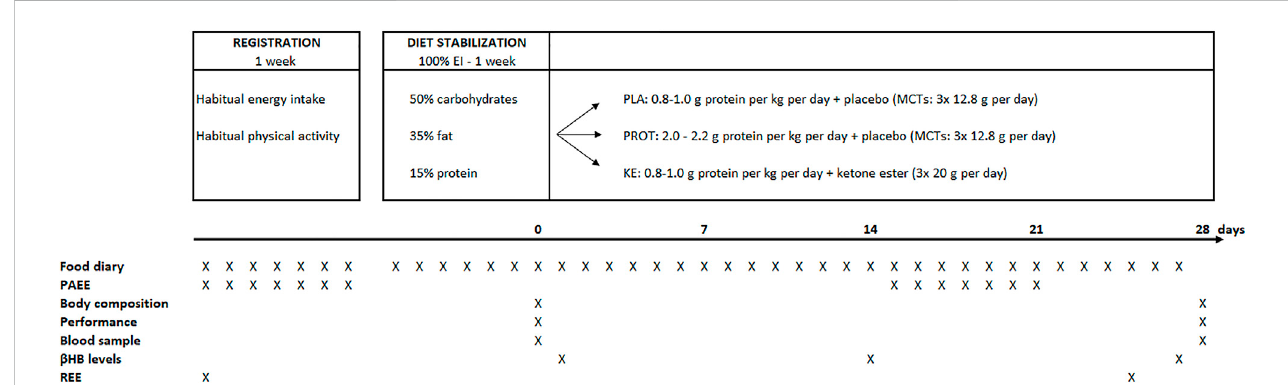
FIGURE 1 Studydesignandtimingofmeasurements. EI,e nergyintake;MCTs,medium chaintriglycerides;PAEE,physicalactivity-relatedenergyexpenditure; β HB, β -hydroxybutyrate; REE, resting energy expenditure.